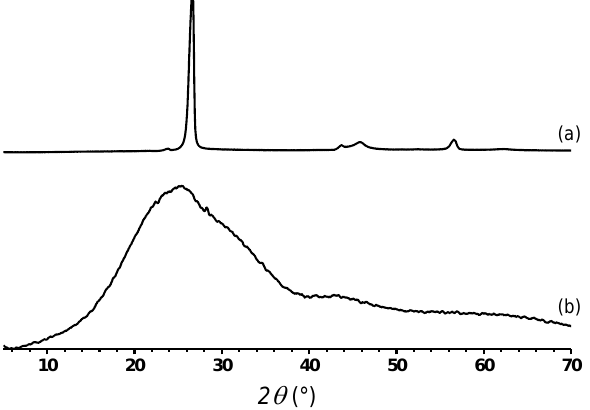
Figure 2. XRD patterns of graphite ( a ) and TrGO ( b ).